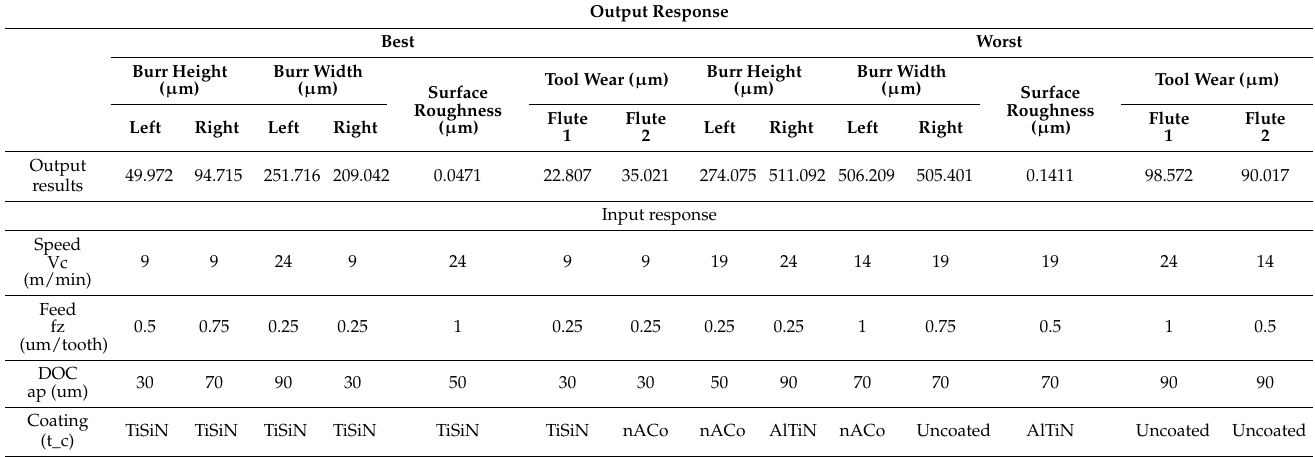
Table 4. Machining parameter combinations for individual best and worst